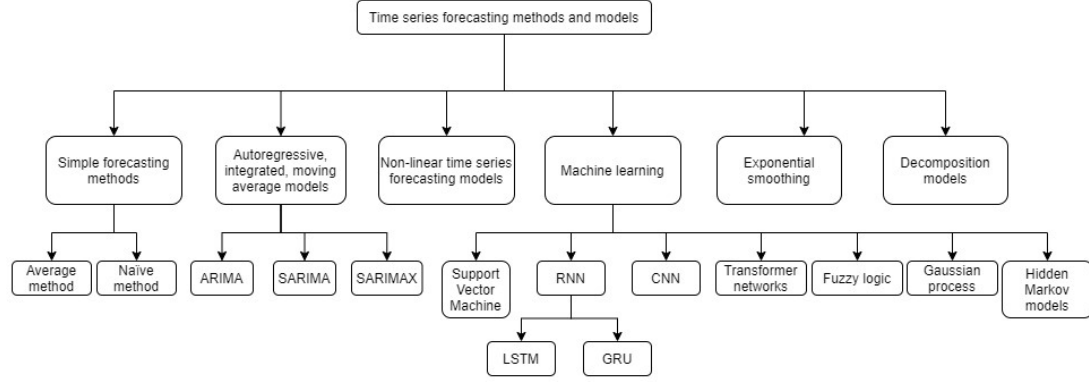
Fig. 1. Classification of time series forecasting methods and